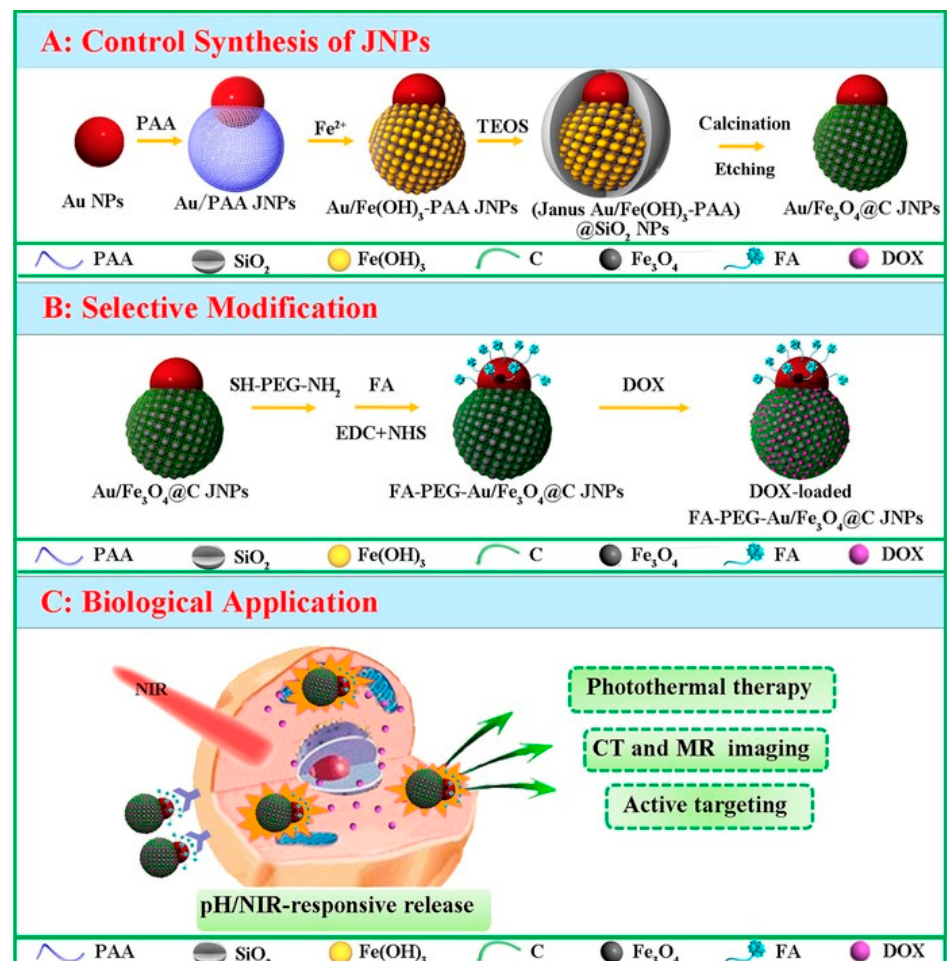
Figure 9. Scheme showing the controlled synthetic strategy for obtaining Au / Fe 3 O 4 @C JNPs ( A ).